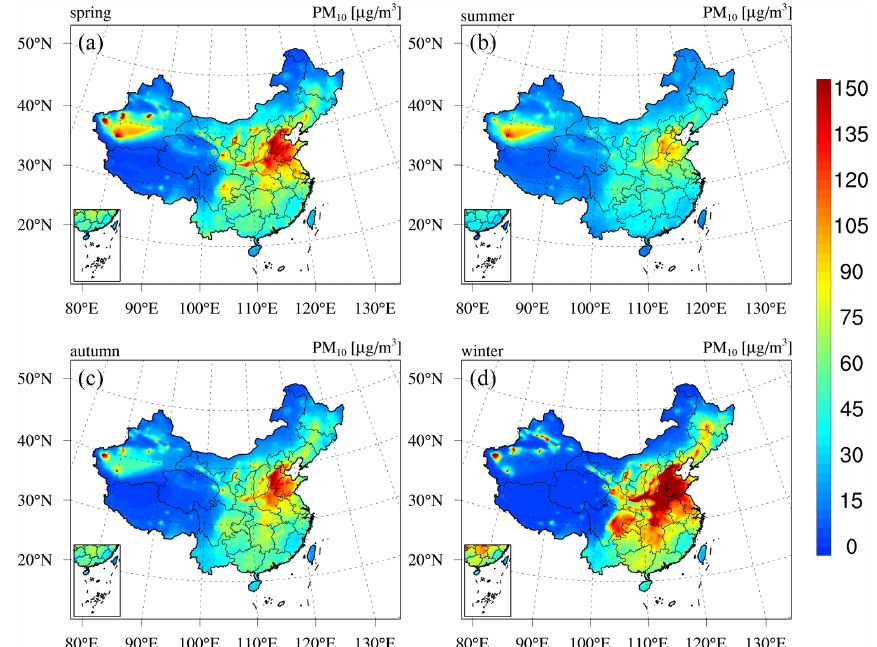
Figure D2. Same as Fig. D1 but for PM 10